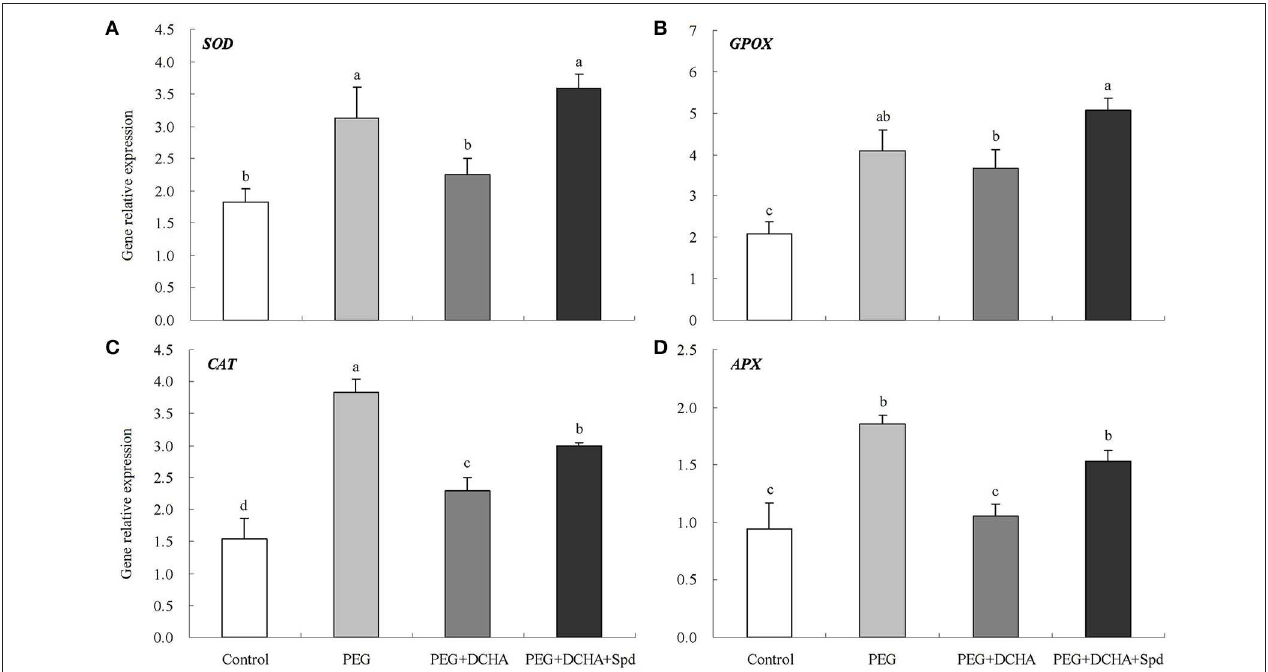
FIGURE 9 | Gene transcript levels encoding antioxidant enzymes as affected by polyamines (PA) under PEG-induced water stress. SOD gene (A) , GPOX gene (B) , CAT gene (C) , and APX gene (D) . The detached leaves of white clover were pre-treated with distilled water for 1h to eliminate wound stress and then treated for 2h as follows: 1, distilled water (control); 2, 15% PEG; 3, 15% PEG + 100 µ M dicyclohexylamine (DCHA); 4, 15% PEG + 100 µ M DCHA + 20 µ M Spd. Means of four independent samples are presented. Bars represent standard errors. The same letter indicates no significant difference (LSD) at P < 0.05.